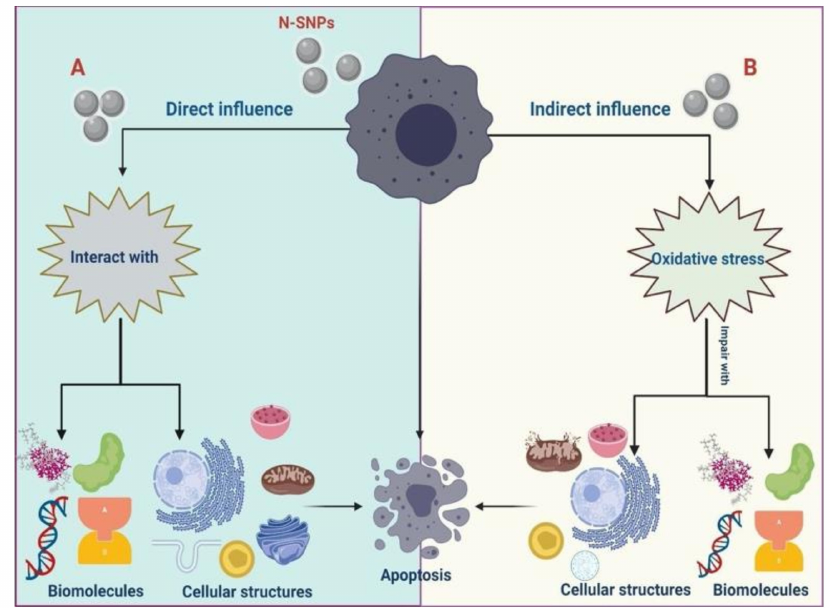
Figure 13. Possible strategies by which N-SNPs kill cancer cells.